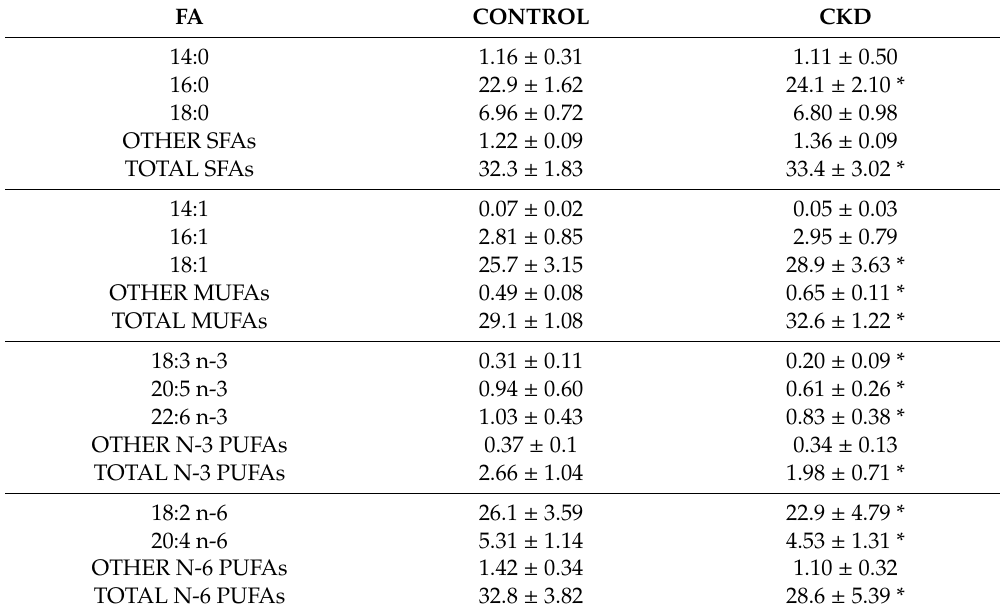
Table 1. The percent content of the main classes of fatty acids in the serum of patients with chronic kidney disease (CKD) and the control group. The data are presented as fatty acid proportions (%). Values are the mean ± SD.